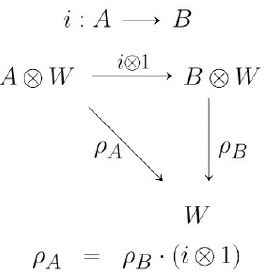
Figure 1 . Sub-algebra representation